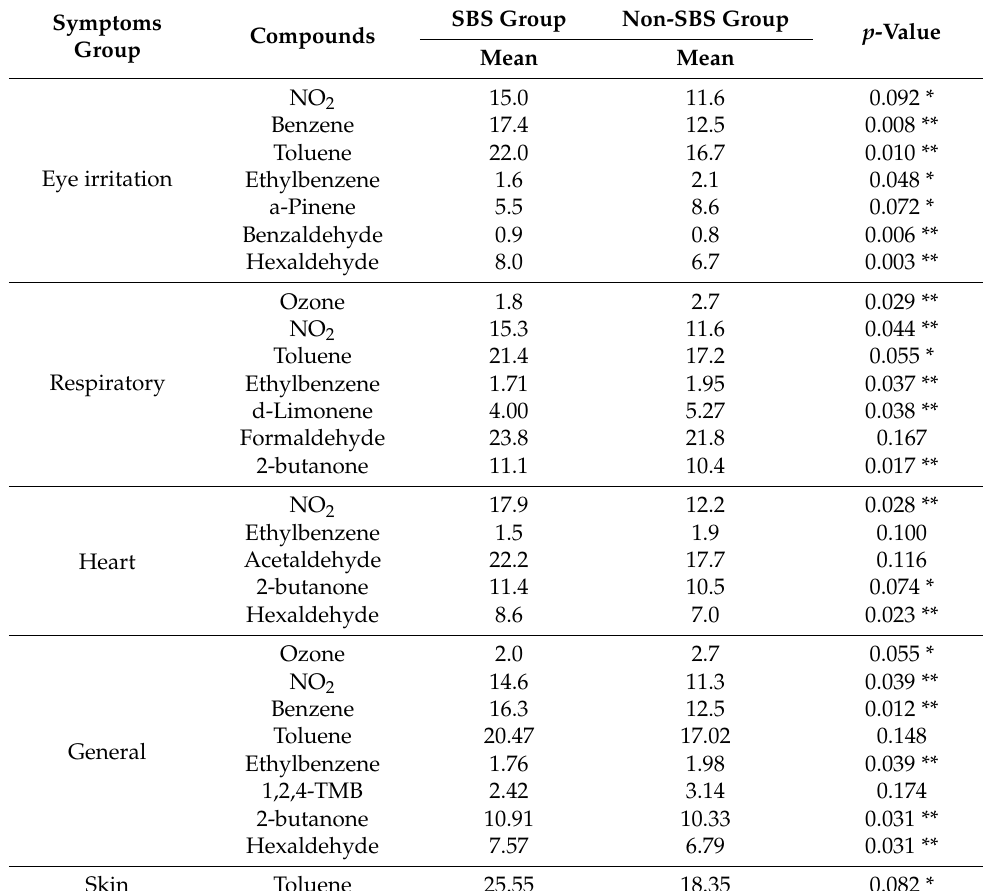
Table 5. Differences in indoor concentrations ( µ g/m 3 ) between SBS and non-SBS among symp- tom